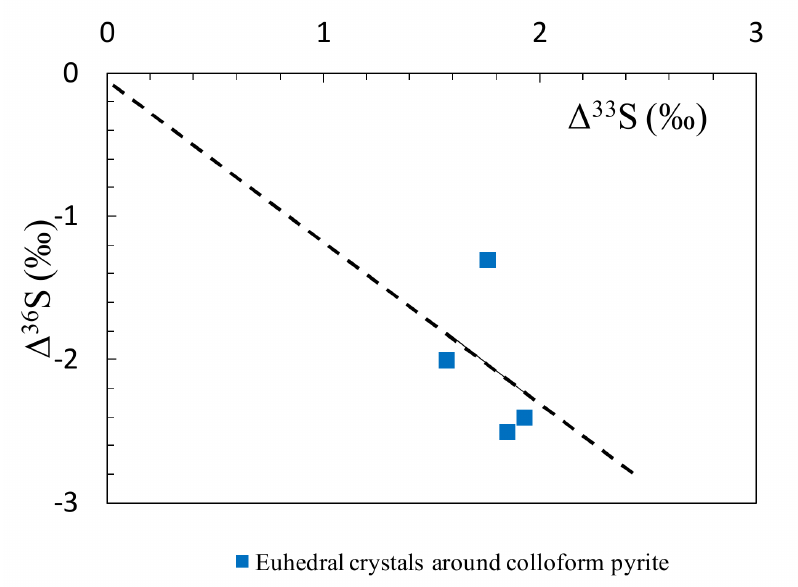
Figure 5. ∆ 36 S vs. ∆ 33 S values for a subset of the euhedral pyrite samples. Data from Table A1 in Appendix A. The dashed line is linear fit to data with a slope of −